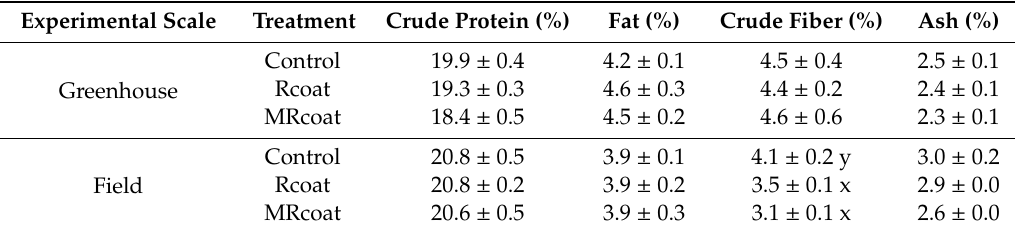
Table 3. Crude protein, fat, crude fiber and ash content of chickpea grains in di ff erent inoculation treatments (control, Rhizophagus irregularis (Rcoat), mixture of R. irregularis isolates (MRcoat)) under greenhouse and field conditions.